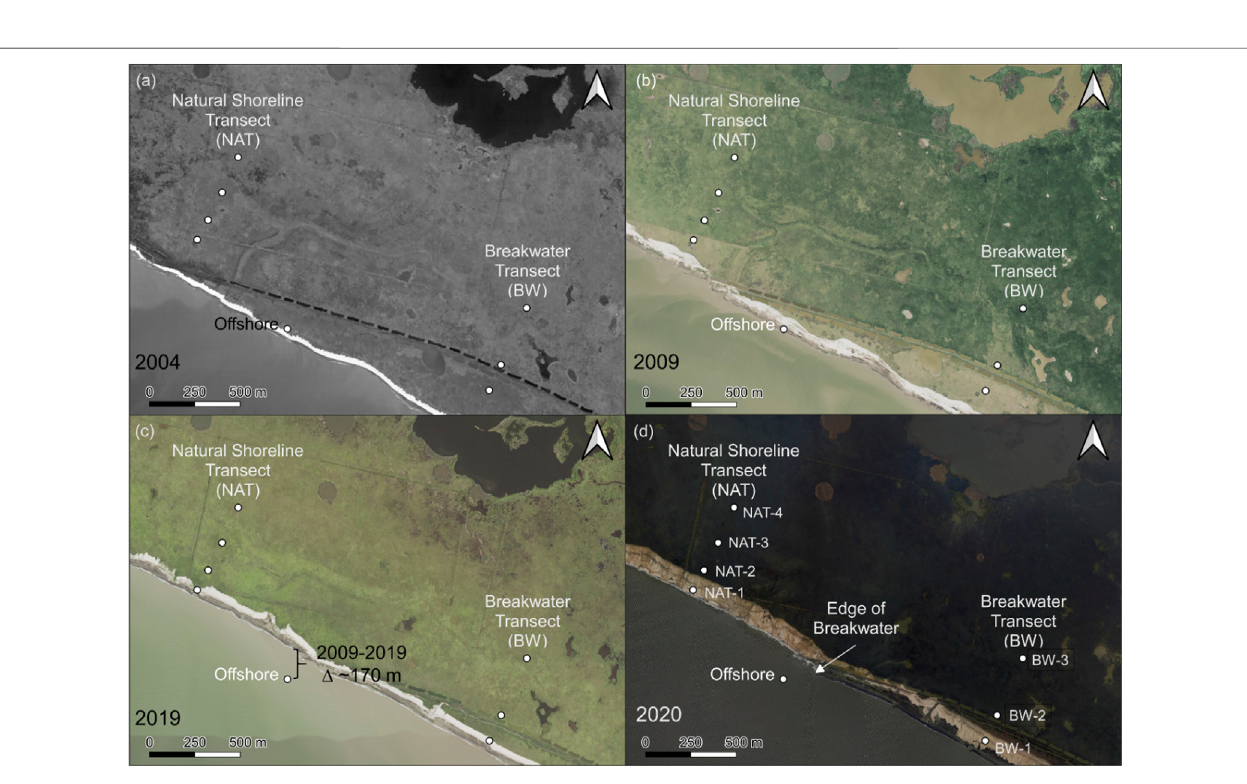
Frontiers in Built Environment |